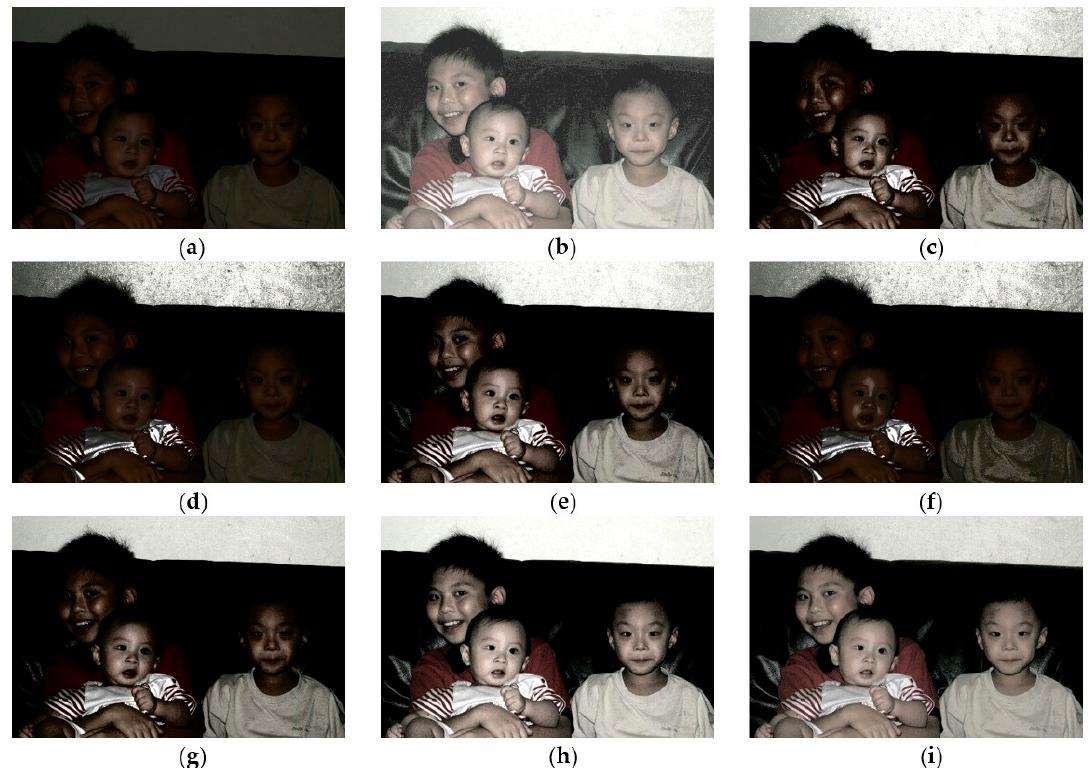
Figure 7. Results of different methods for the image Brothers (image size: 960 × 640 pixels): ( a ) Original image; ( b ) HE; ( c ) BBHE; ( d ) RMSHE (r = 2); ( e ) DSIHE; ( f ) RSIHE (r = 2); ( g ) DQHEPL; ( h ) VCEA; and ( i ) CegaHE.